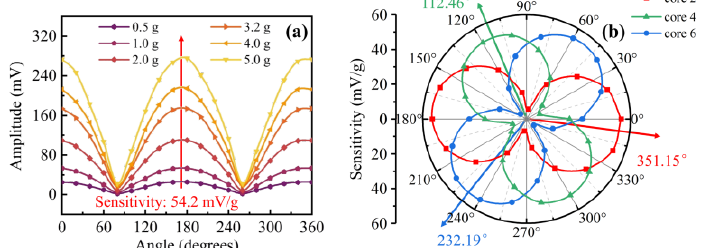
Figure 5. ( a ) Orientation response of core 2 at different accelerations ranging from 0.5 to 5.0 g; ( b ) acceleration sensitivities of the FBGs in the three outer cores 2, 4, and 6, plotted for various orientation angles in polar coordinate.